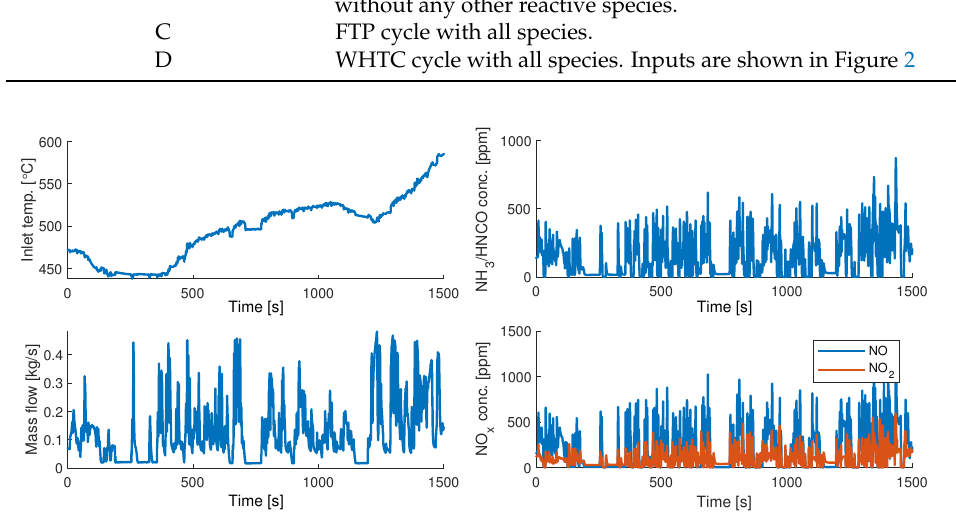
Figure 2. Inputs from the WHTC drive